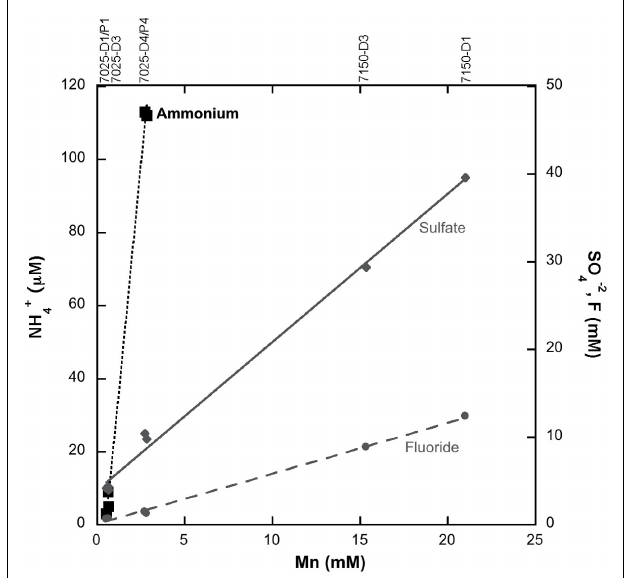
FIGURE 1 |The fluid chemistry of five boreholes from two levels within Henderson Mine demonstrate linear correlations between Mn and F − or SO 42 − as recognized by Sahl et al. (2008), which is interpreted as mixing between a rock-reacted fluid and meteoric water. NH 4 + concentrations for the boreholes 7025-D1/P1 and 7025-D1/P4 as reported by Sahl et al. (2008) and additional data from borehole 7025-D3 reported here suggest that ammonium may also source from water-rock